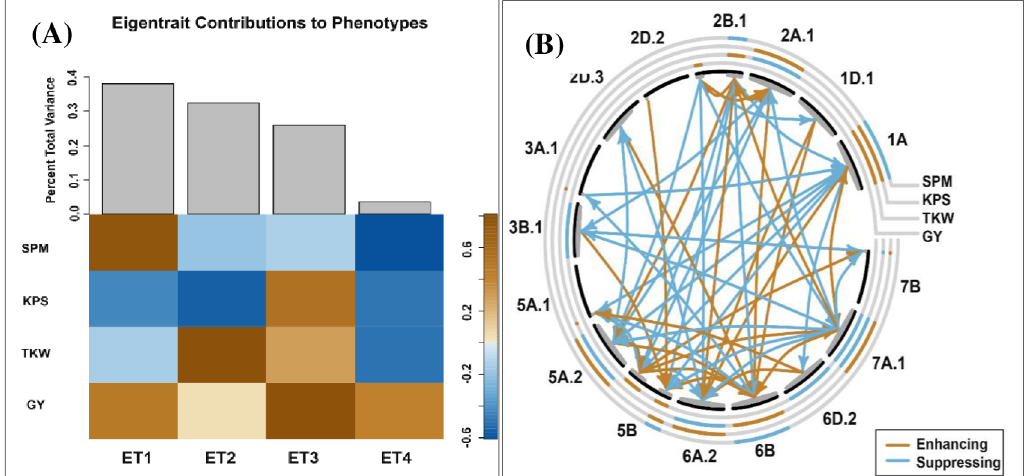
Fig 3. Interactions and pleiotropic patterns based on markerslinked to significant QTL from multi- environment and multi-trait QTL analysis. ( A) Eigentraits(ET) generatedthrough singularvalue decomposition of phenotypic data. The first three ET explainedapproximately 90% of the phenotypic variationand were used for combinedanalysisof pleiotropyand epistasis (CAPE). The legendindicatesthe directionof varianceamongtraits. For instance,for ET1, kernel spike -1 (KPS) and thousandkernel weight (TKW) vary in oppositedirectioncomparedto grain yield (GY) and spike m -2 (SPM). ( B) Interaction patterns from CAPE with main effects (brown and blue) depictedon the concentricrings and interactionsdepicted by color-codedarrow lines within the plot. Brown arrow line represents enhancing effect whereasblue arrow line indicatesrepressingeffect.